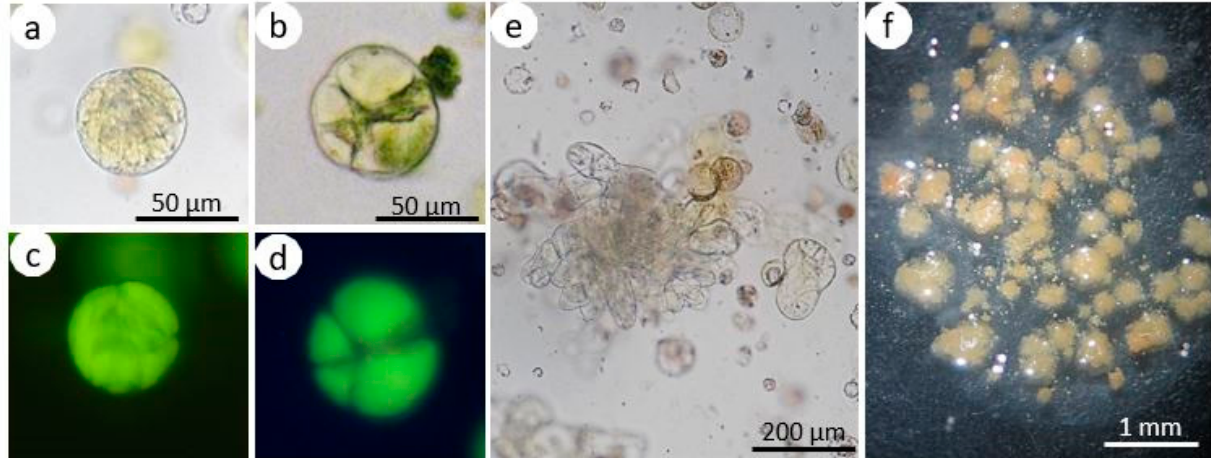
Figure 4. Culture of hypocotyl-derived protoplasts of Brassica oleracea L. var. capitata. Fluorescein diacetate (FDA)-stained protoplast culture on the first ( a , c ) and fifth day ( b , d ) visible in white light ( a , b ) and under UV light ( c , d ). The upper and lower pictures show the same view. Multicell aggregate ( e ); alginate layer overgrown with callus colonies ( f ). Table 1. Mean effect of the accession and exogenous putrescine (Put), spermidine (Spd), and spermine (Spm) on the viability of the protoplast-derived cells of Brassica oleracea L. var. capitata. The values are the means ± SE ( n = 60). The data in columns denoted with the same letter were not significantly different ( p ≤ 0.05, Tukey’s honestly significant difference test (HSD)). Cell Viability (%)(mean ± SE) Factor First Day Fifth Day Accession: Sława z Goł˛ebiewa